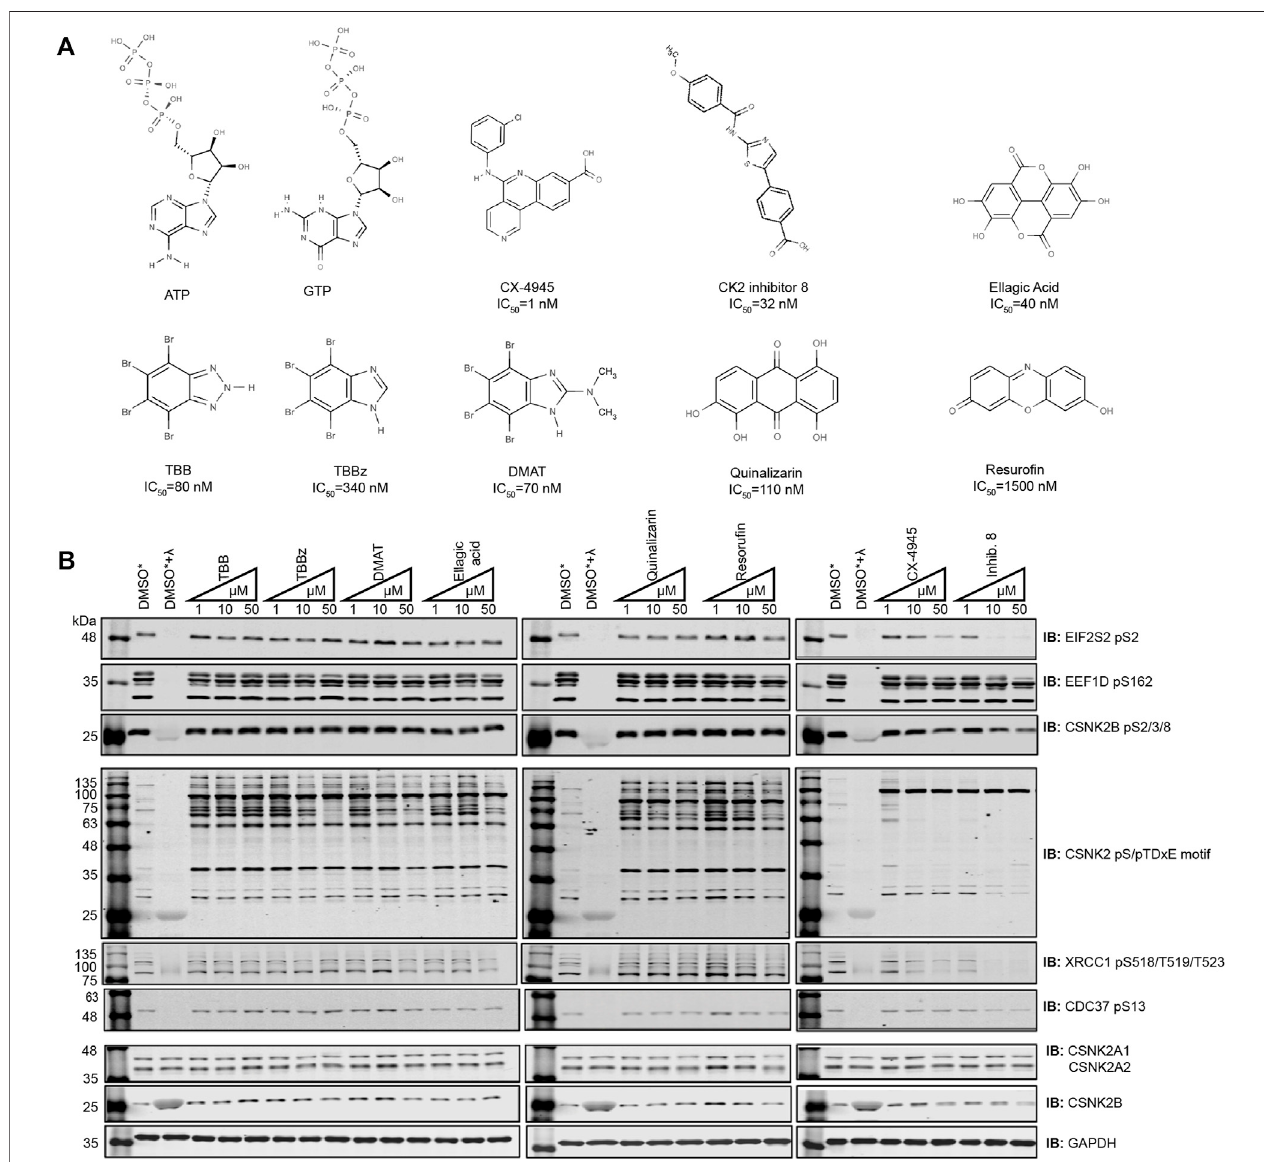
FIGURE 1 | Comparing the ef fi cacy of CSNK2 inhibitors in U2OS cells. (A) Schematic illustration of the CSNK2 inhibitors that were evaluated in this study with reported in vitro IC 50 values (B) CSNK2 inhibition was assessed by immunoblotting with the indicated phospho-speci fi c antibodies after 24 h of inhibitor CX-4945 treatment at the indicated concentrations in U2OS cells. Lysis buffer of lysates marked with * did not contain phosphatase inhibitors. DMSO treated lysates +/- λ - phosphatase were used as immunoblotting controls for the phospho-speci fi c antibodies. Results are representative of two independent experiments.